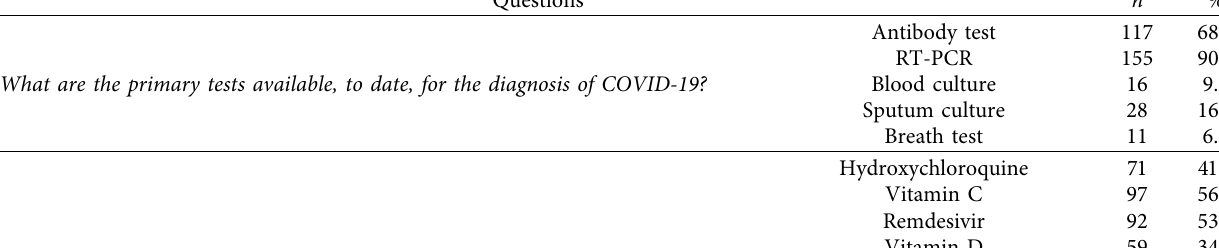
Figure 2: Association of level of COVID-19-related knowledge of the residents with their response selected regarding the symptoms of COVID-19 Table 3: Outcomes on tests available, treatment options present, and PPE recommendation for COVID-19. Questions n